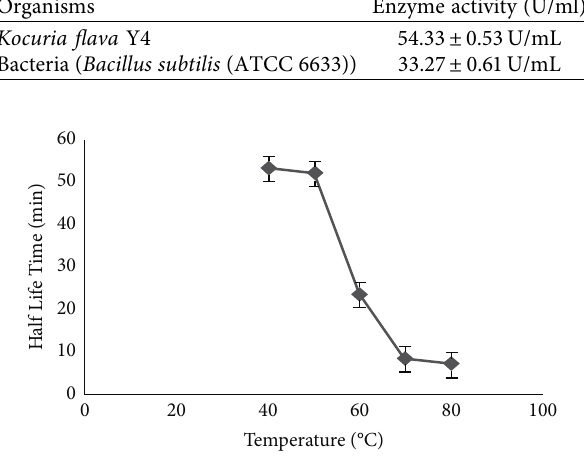
Figure 3: Thermal stability